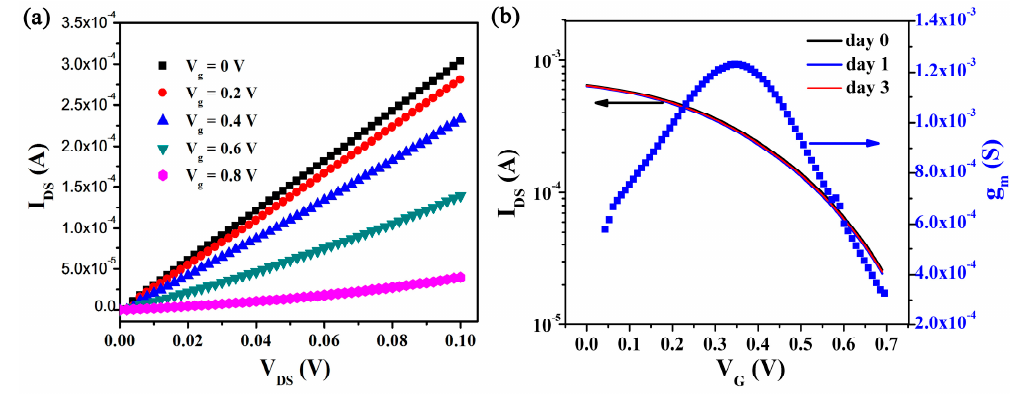
Figure 2. Characteristics of the OECT device array. ( a ) Output characteristic of a single OECT measured in culture medium; ( b ) Transfer characteristic of a single OECT measured in culture medium in 3 days at V DS = 0.1 V and the resulting transconductance g m .